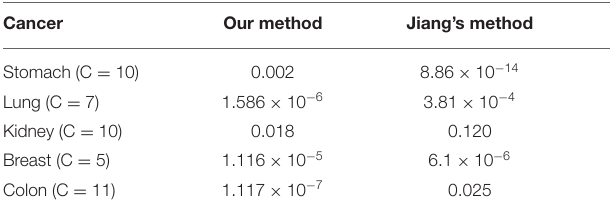
TABLE 4 | Performance of different methods on Jiang’s dataset. TABLE 5 | Performance of our method on Novel